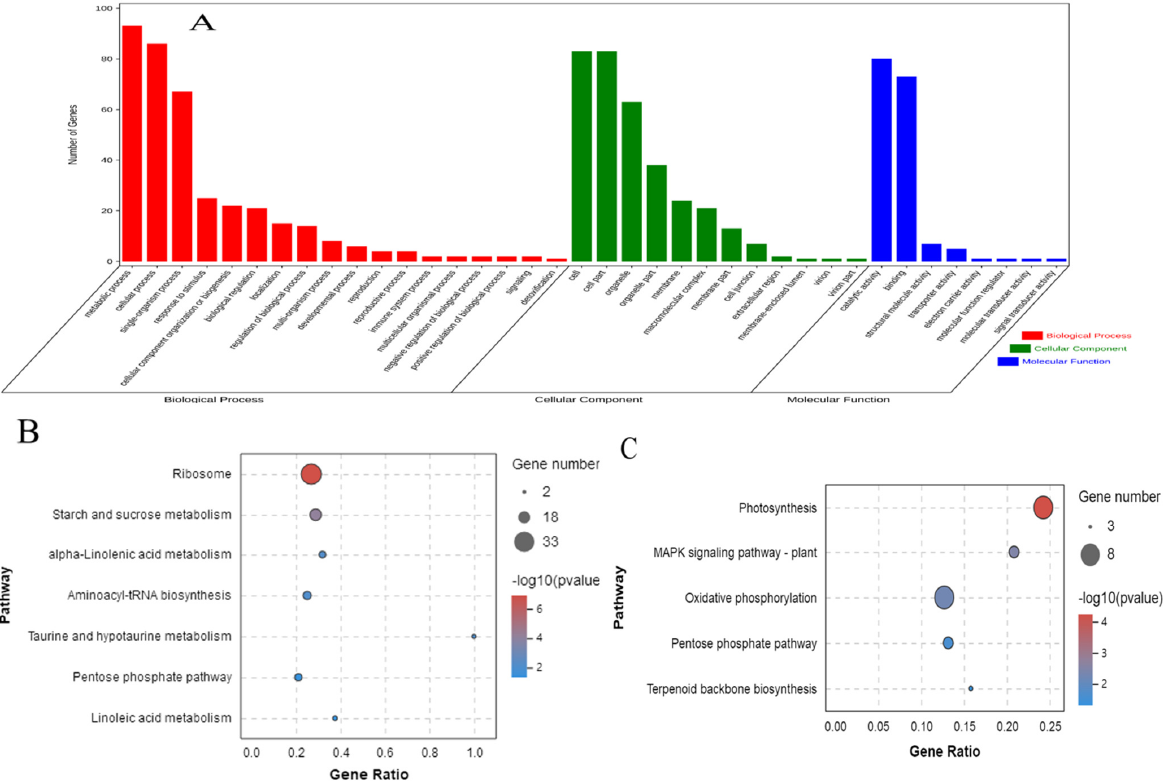
Figure 7. ( A ) GO-based enrichment analysis of differentially expressed proteins (DEPs) in leaves of Rhododendron delavayi under BR treatment; ( B ) Significantly enriched ( p < 0.05) pathway of up-accumulated DEPs under BR treatment; ( C ) Significantly enriched ( p < 0.05) pathway of down-accumulated DEPs under BR treatment. Table 1. Significantly enriched KEGG pathways of differentially expressed proteins (DEPs) specific to 24-epibrassionlide (BR) treatment, drought (D) treatment, and shared between the BR and D treatments. Pathway DEPs with Pathway All Proteins with p -Value Pathway Annotation